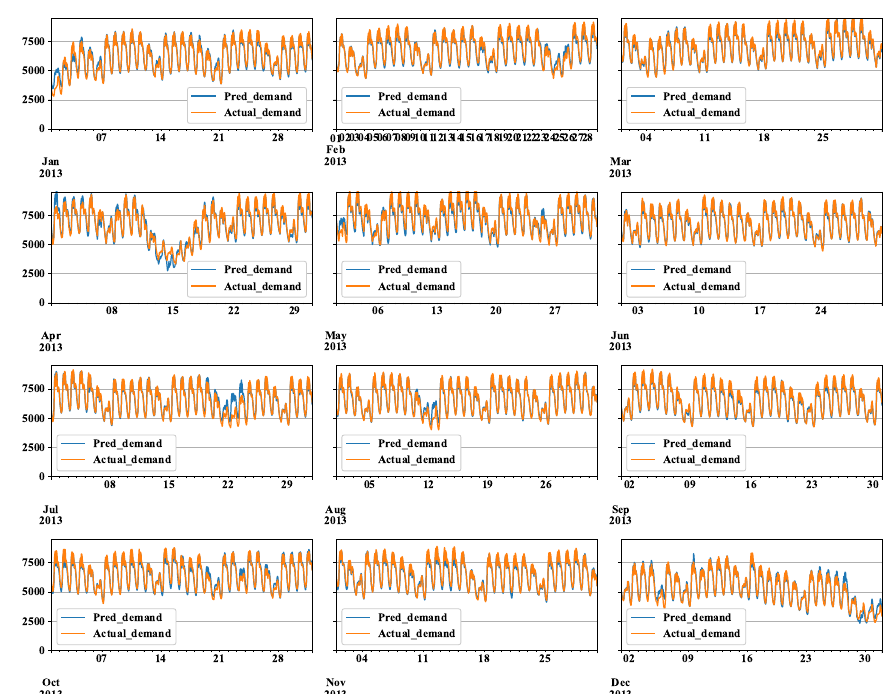
Figure A9. Forecasting performance of OLS (Scenario